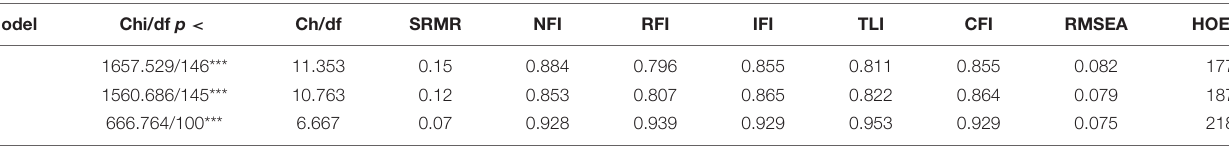
TABLE 1 | Statistical values of the models tested.